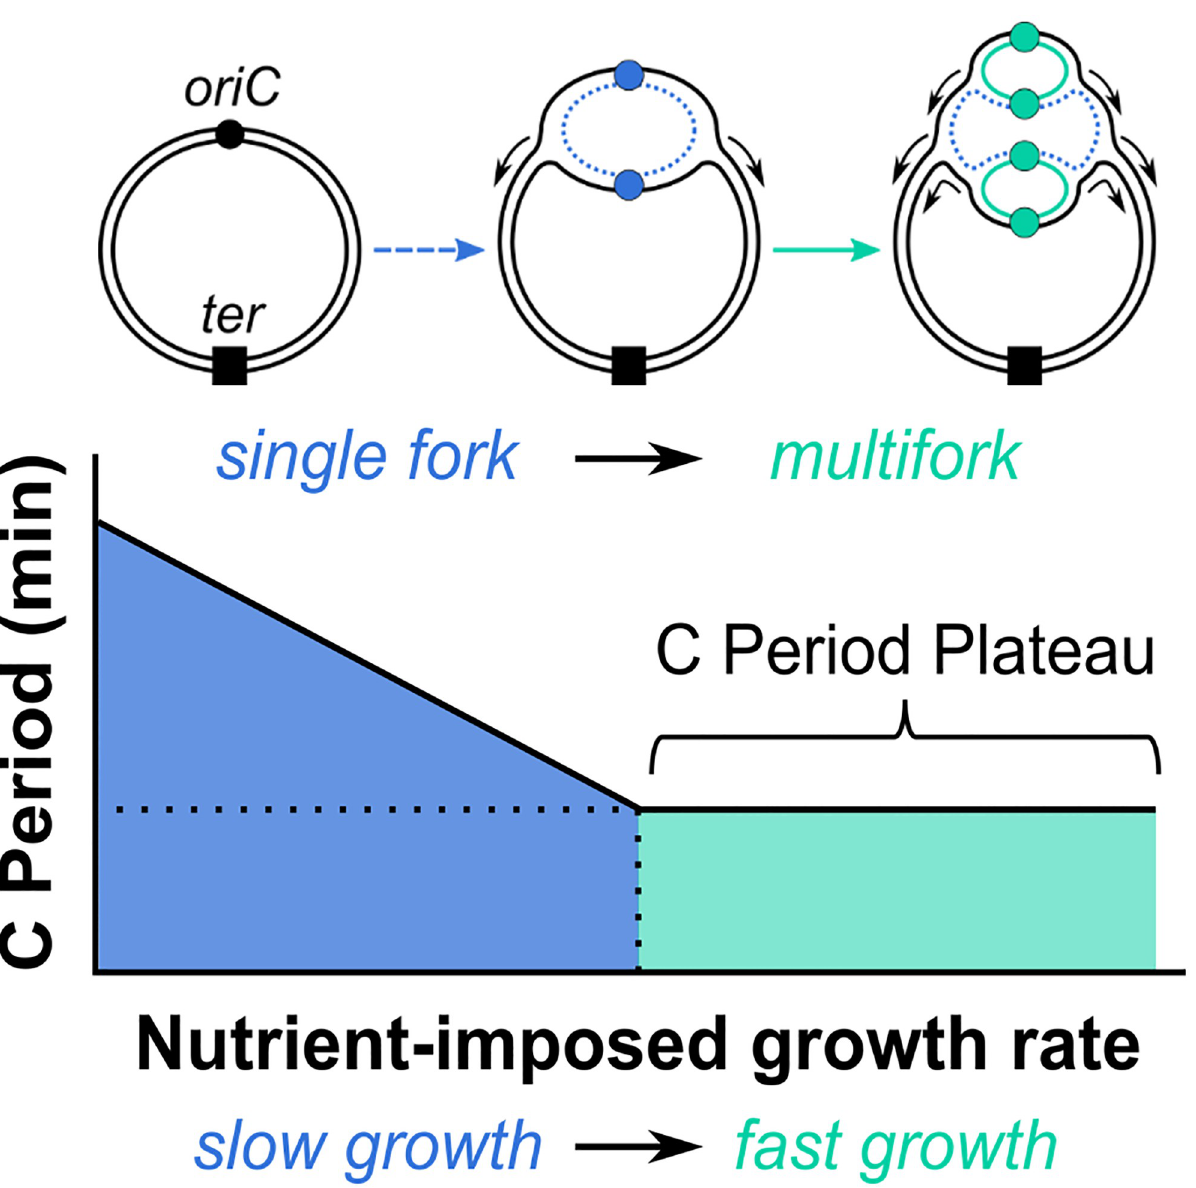
Fig 1. Replication of the E . coli chromosome. Top: Bacterial chromosome depicting the origin of replication ( oriC , ● ) and terminus (ter , & ). After birth, replication initiation yields a single replication bubble, a replication state termed “single fork replication” (- - -). When a second initiation event occurs before termination of the prior round, “multifork replication” occurs (—). Active origins and newly synthesized DNA are indicated with colors corresponding to replication state. Bottom: In the Cooper–Helmstetter model, as nutrient-imposed growth rate increases, the C period length decreases until it reaches a plateau during fast